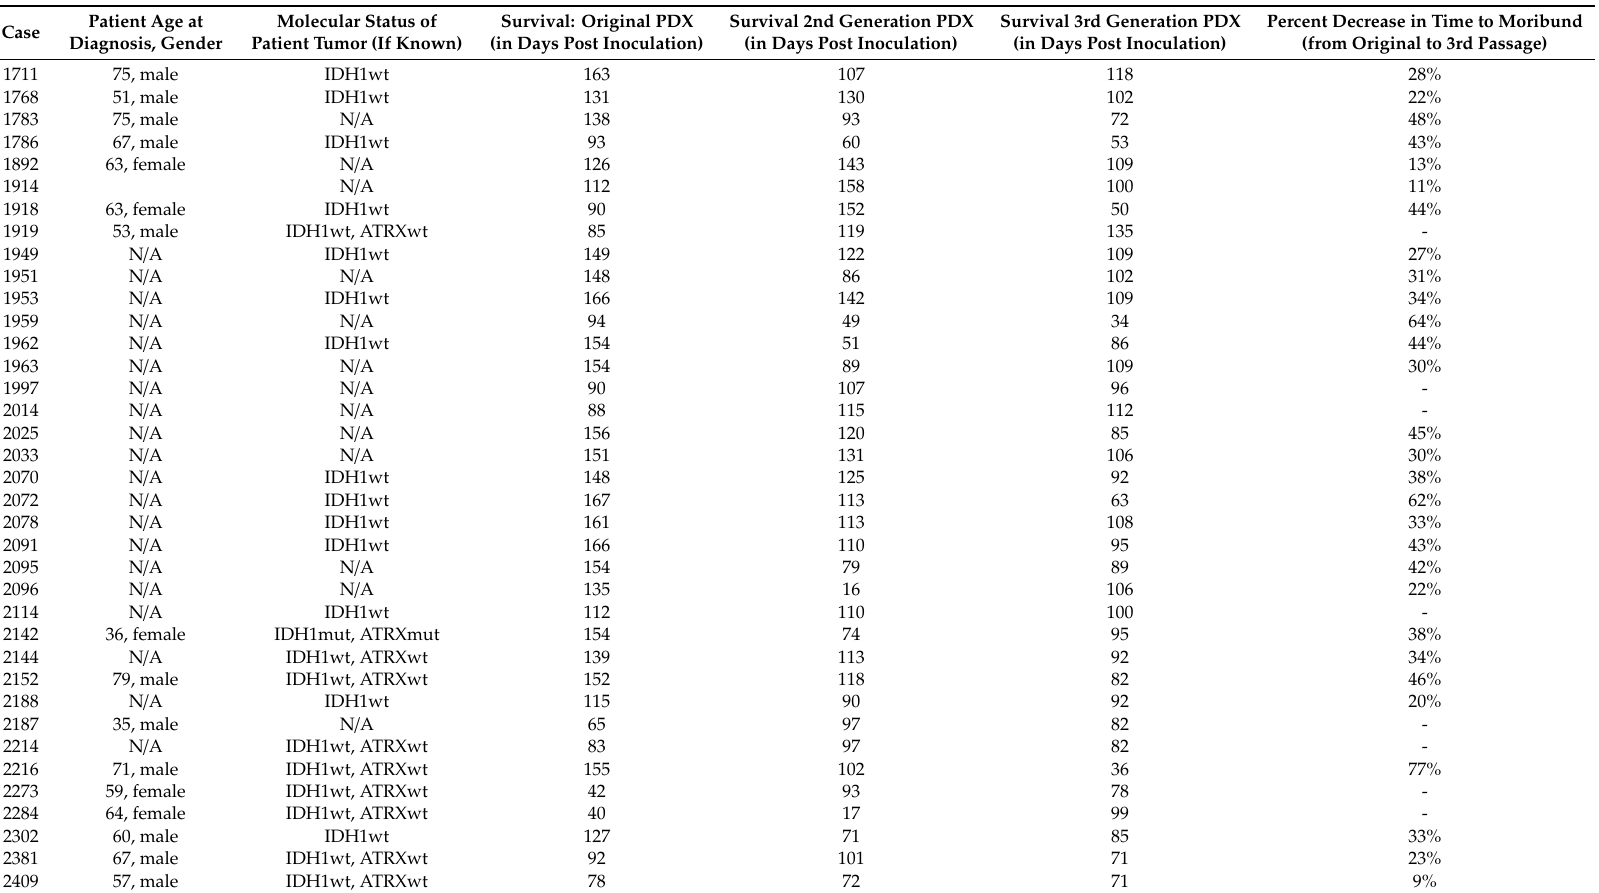
Table 1. Characteristics of GBM patient-derived intracranial xenografts. The table lists the 37 patient-derived xenograft (PDX) models which contained enough viable cells for at least three intracranial passages and represents about 54% of the patient samples excised. Each column is an average growth rate in number of days from the initial implant of the cells until moribund ( n = 2). The last column shows the percent decrease in time for symptom development from the first to the last passage. Eleven cases demonstrated a 40% or more decrease in days as the passage number increased. Dashes represent cases where no increase in symptom development was found in subsequent tumor cell passage. No correlation between age at diagnosis or gender was determined to be a factor in the take rate of the